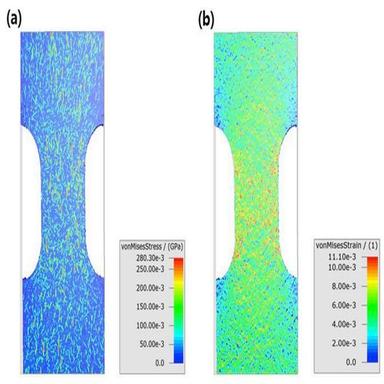
Microscopic tension response of the SBF/PA6,6 composites in the uniaxial deformation with 1% tensile loading in the Z direction for the tensile specimen: (a) Von Mises stress and (b) Von Mises strain.